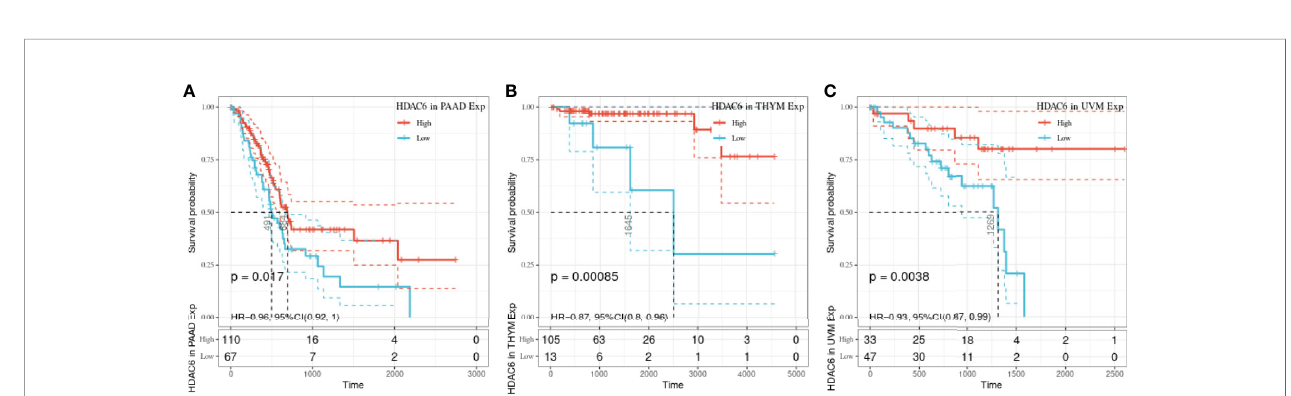
FIGURE 3 | Relationship between HDAC6 and PAAD, THYM, and UVM OS. (A) The relationship between HDAC6 high and low expression levels and PAAD OS was analyzed using K – M survival. (B) Relationship between HDAC6 high and low expression levels and THYM OS using K – M survival analysis. (C) The relationship between HDAC6 high and low expression levels and UVM OS using K – M survival analysis.